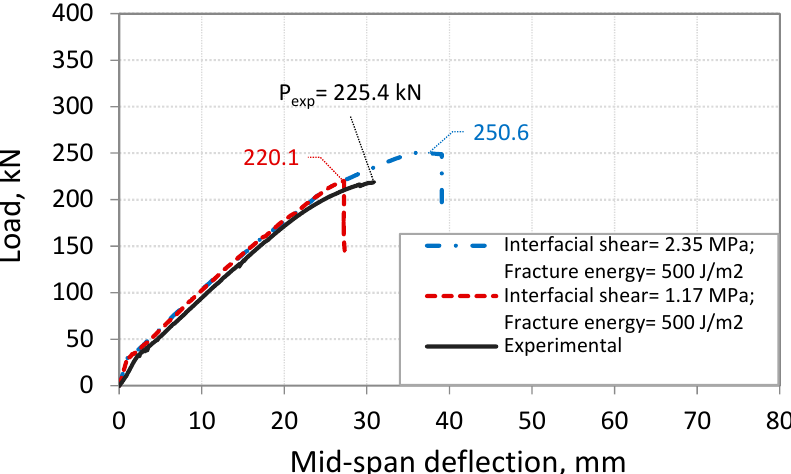
Figure 9. Comparison between experimental and FE results for different values of τ max .